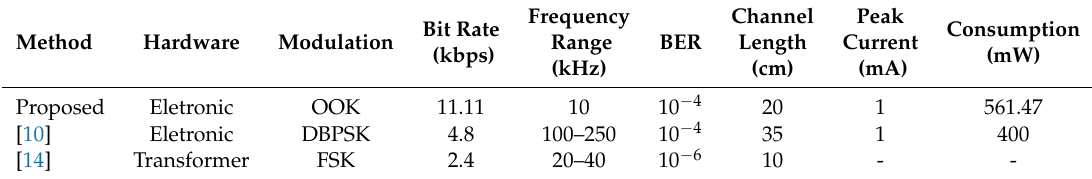
Table 4. Main results compared to the most significant related